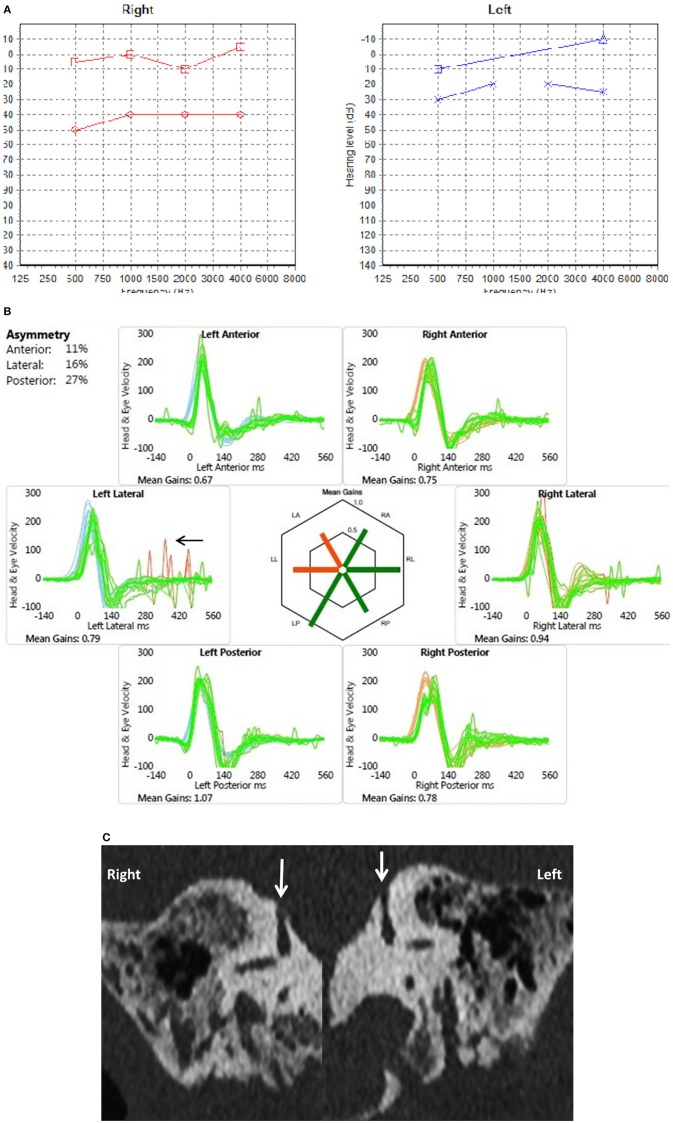
(A) PTA in a child presenting with conductive hearing loss on both sides (child 6). (B) Video head impulse test in the same child with overt replicable saccades in the left lateral semicircular plane (arrow). (C) Coronal reconstruction of High resolution CT scan shows dehiscence of the superior semicircular canal on both sides (arrows).